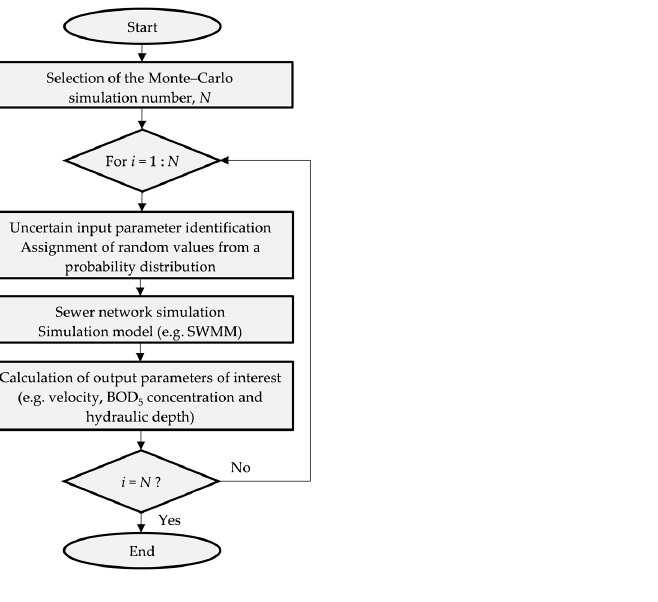
Figure 3. The Monte-Carlo simulation procedure.